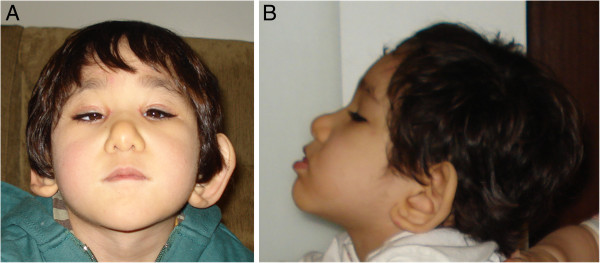
Patient phenotype at 5 years-old. Frontal (A) >and side (B) view